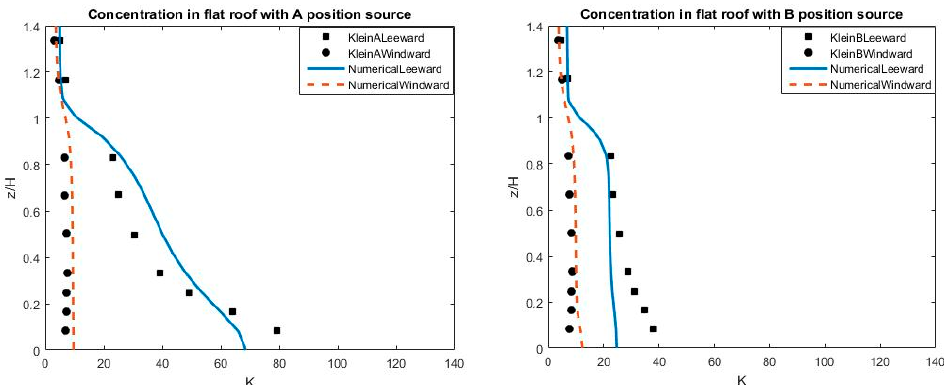
Figure 24. The dimensionless concentration K along the leeward and windward sites in the reference case (flat roof) corresponding to position sources located at A ( left ) and B ( right